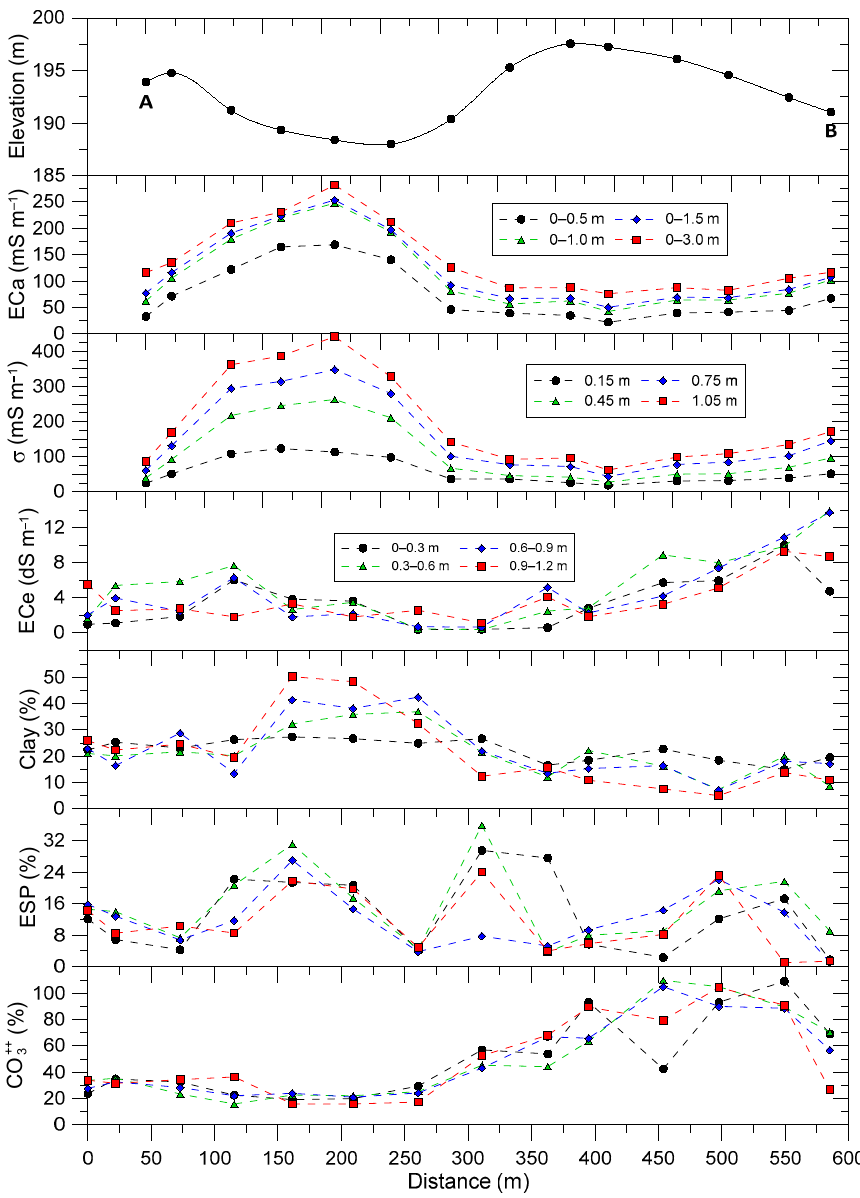
Figure 9. Elevation and different soil properties measured in 2017 along transect T1 A–B (Figure 1).